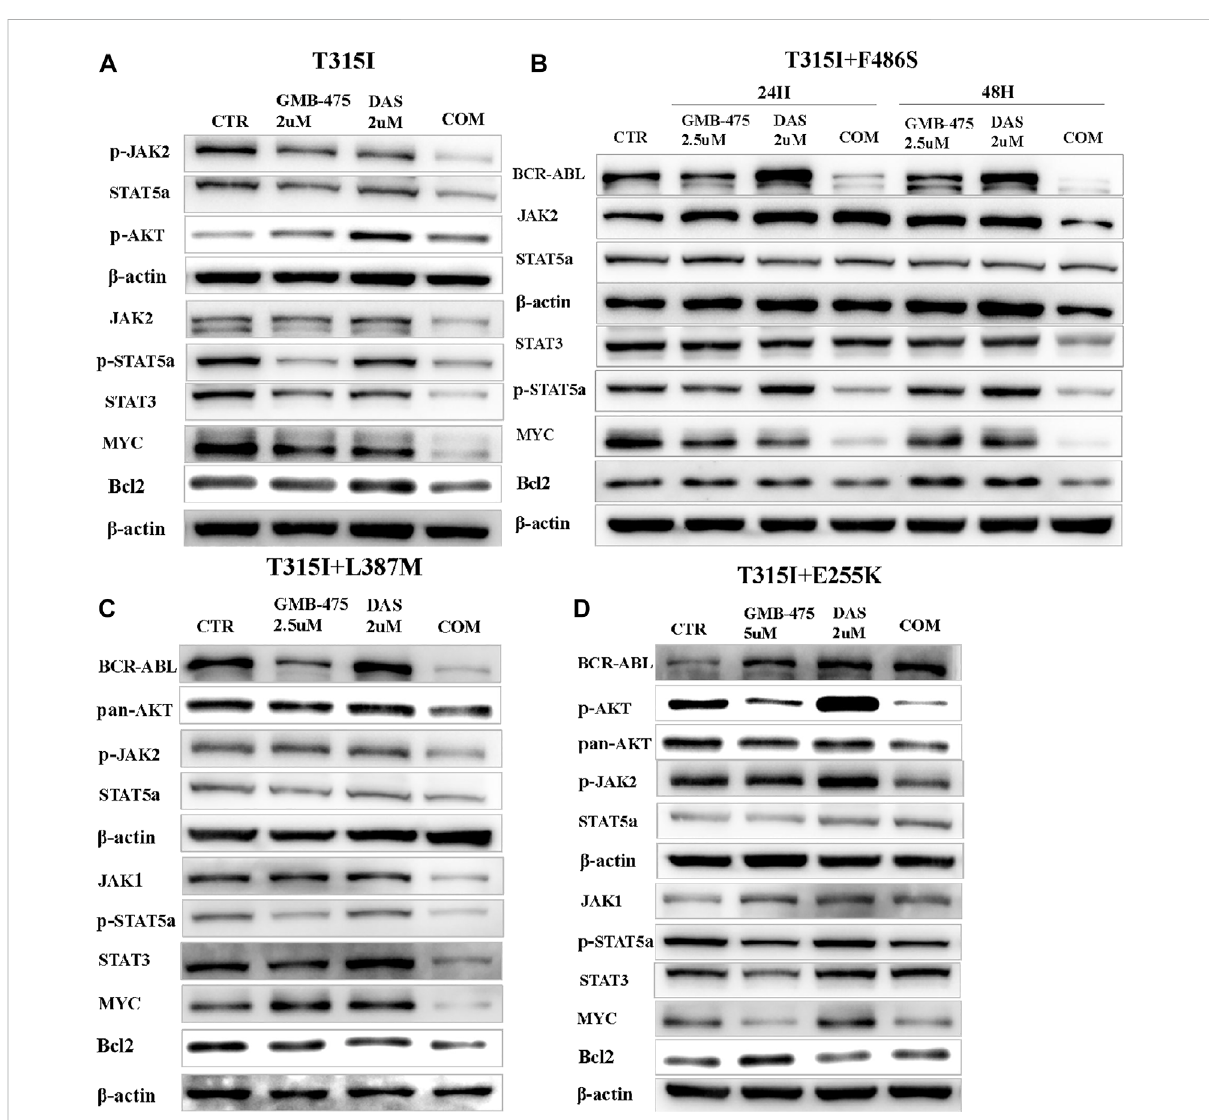
GMB-475 combined with dasatinib synergistically downregulated the protein levels of the JAK-STAT axis or AKT in Ba/F3-MIG-p210 cells with BCR::ABL1mutants.TheproteinlevelsofgenesinBa/F3-MIG-p210cellstreatedwiththecontrolmedium(CTR),GMB-475,dasatinib(DAS),orGMB- 475plusdasatinibweredetectedbywesternblot: (A) Ba/F3-MIG-p210cellscarryingBCR::ABL1 T315I weretreatedwithCTR,GMB-4752 µM,dasatinib 2 µM, and GMB-475 2 µM plus dasatinib 2 µM for 48 h. (B,C) Ba/F3-MIG-p210 cells carrying BCR::ABL1 T315I+F486S and BCR::ABL1 T315I+L387M compound mutations were treated with CTR, GMB-475 2.5 µM, dasatinib 2 µM, and GMB-475 2.5 µM plus dasatinib 2 µM for 48 h, respectively (Ba/ F3-MIG-p210 cells with BCR::ABL1 T315I+F486S were treated for 24 and 48 h). (D) Ba/F3-MIG-p210 cells carrying BCR::ABL1 T315I+E255K were treated